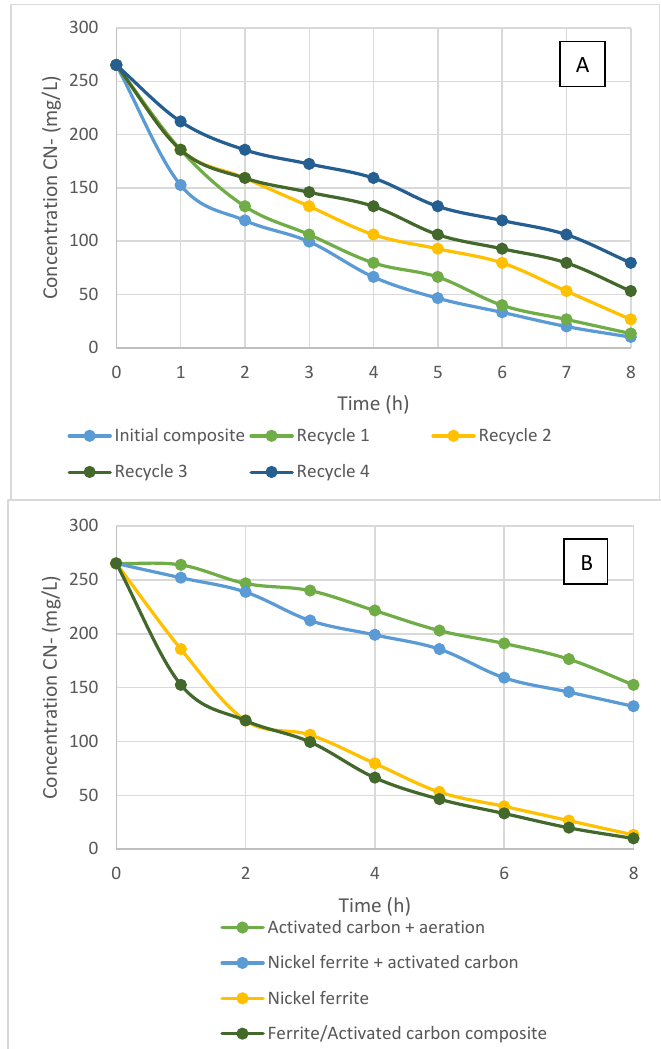
Fig. 8: Cyanide oxidation kinetics. (a) Recyclability tests of the R1/1 OA composite, (b) Comparison of catalysts studied. (15 g/L, 180 NL/h, 5.5-8.5 mg O 2 /L, 800 rpm) Table 4: Parameters of the reaction kinetics of the prepared composites Catalyst